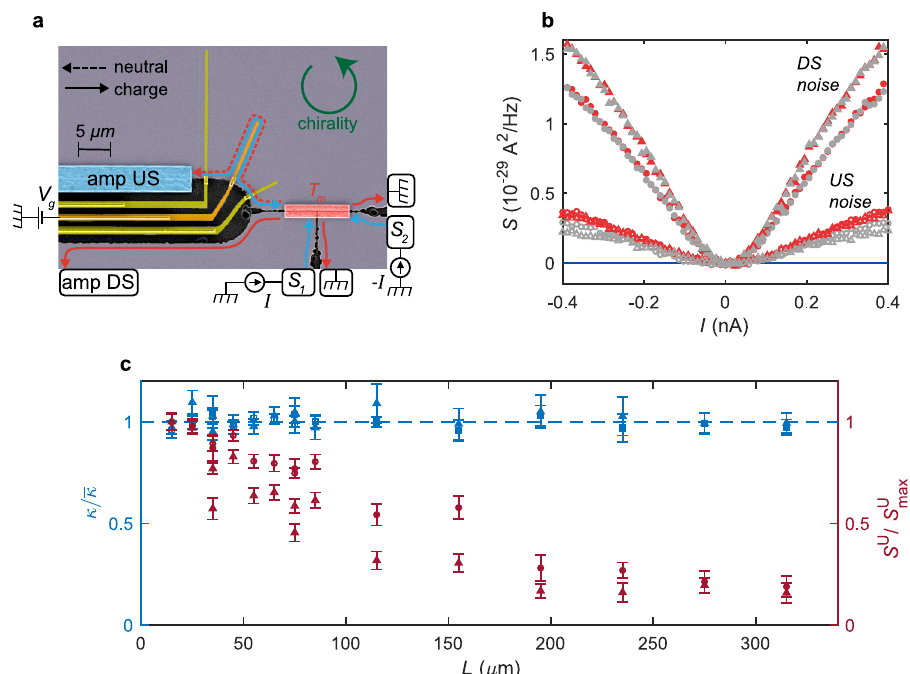
Fig. 3 Length pro fi le of the thermal conductance and the upstream noise. a False colors SEM image of the central part of Device B1. The mesa (gray) is divided into three arms by the etched regions (black). The three arms are connected by a fl oating metallic island (in red) with area 15 ´ 2 μ m 2 , serving as a heat source. When a current I from S and - I from S are sourced simultaneously, the fl oating island heats up to a temperature T . The resulting noise is 1 2 m measured simultaneously in the downstream and upstream ampli fi ers. The propagation length from the fl oating contact to the upstream ampli fi er can be varied using the metallic gates (yellow, as in Device A). Depicted is the case where the middle gate (darker yellow) redirects the path of the edge modes by the application of a gate voltage V g , while the other gates are unbiased, and hence do not affect the propagation length. b Downstream noise (full shapes) and upstream noise (empty shapes) as a function of the current. Results are shown for ν ¼ 2 (triangles) and ν ¼ 3 (circles), and the propagation lengths 3 5 15 μ m (red) and 75 μ m (gray). The upstream-noise decays with length while the downstream noise does not. c Two-terminal thermal conductance κ 2 T (extracted from the downstream noise) (blue), and upstream-noise strength (red) as a function of length (See Methods). The thermal conductance is separately normalized for ν ¼ 2 and ν ¼ 3 with respect to their respective means. For both ν ¼ 2 and ν ¼ 3 , we observe that κ 2 T is length-independent, 3 5 3 5 while the upstream-noise decays (similarly to Fig. 2b). This indicates an unequilibrated thermal regime. The empty (full) shapes mark the data measured in device B1 (B2), and error bars represent the 95% con fi dence bounds of the normalized thermal conductance and the upstream-noise